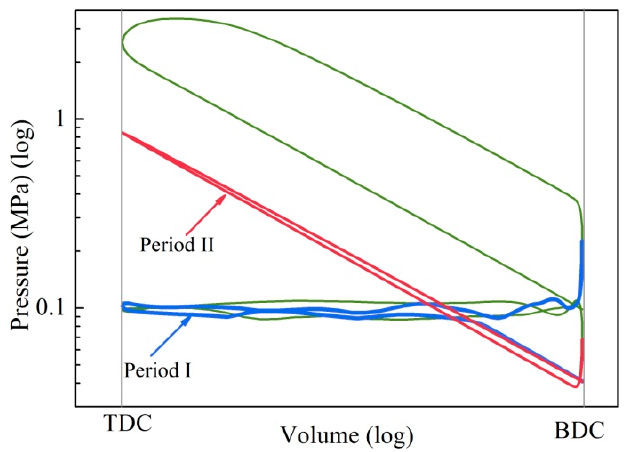
Figure 13. The in-cylinder pressure of one inactive cycle and one active cycle.